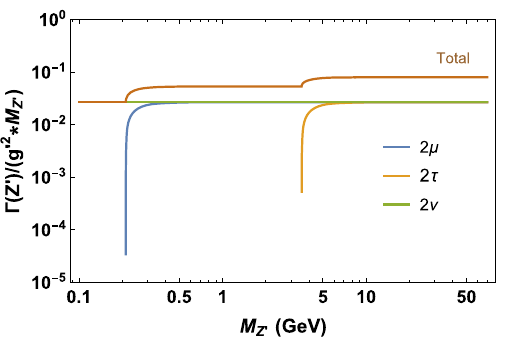
U 13 = (cid:8) r cos θ W cos χ,